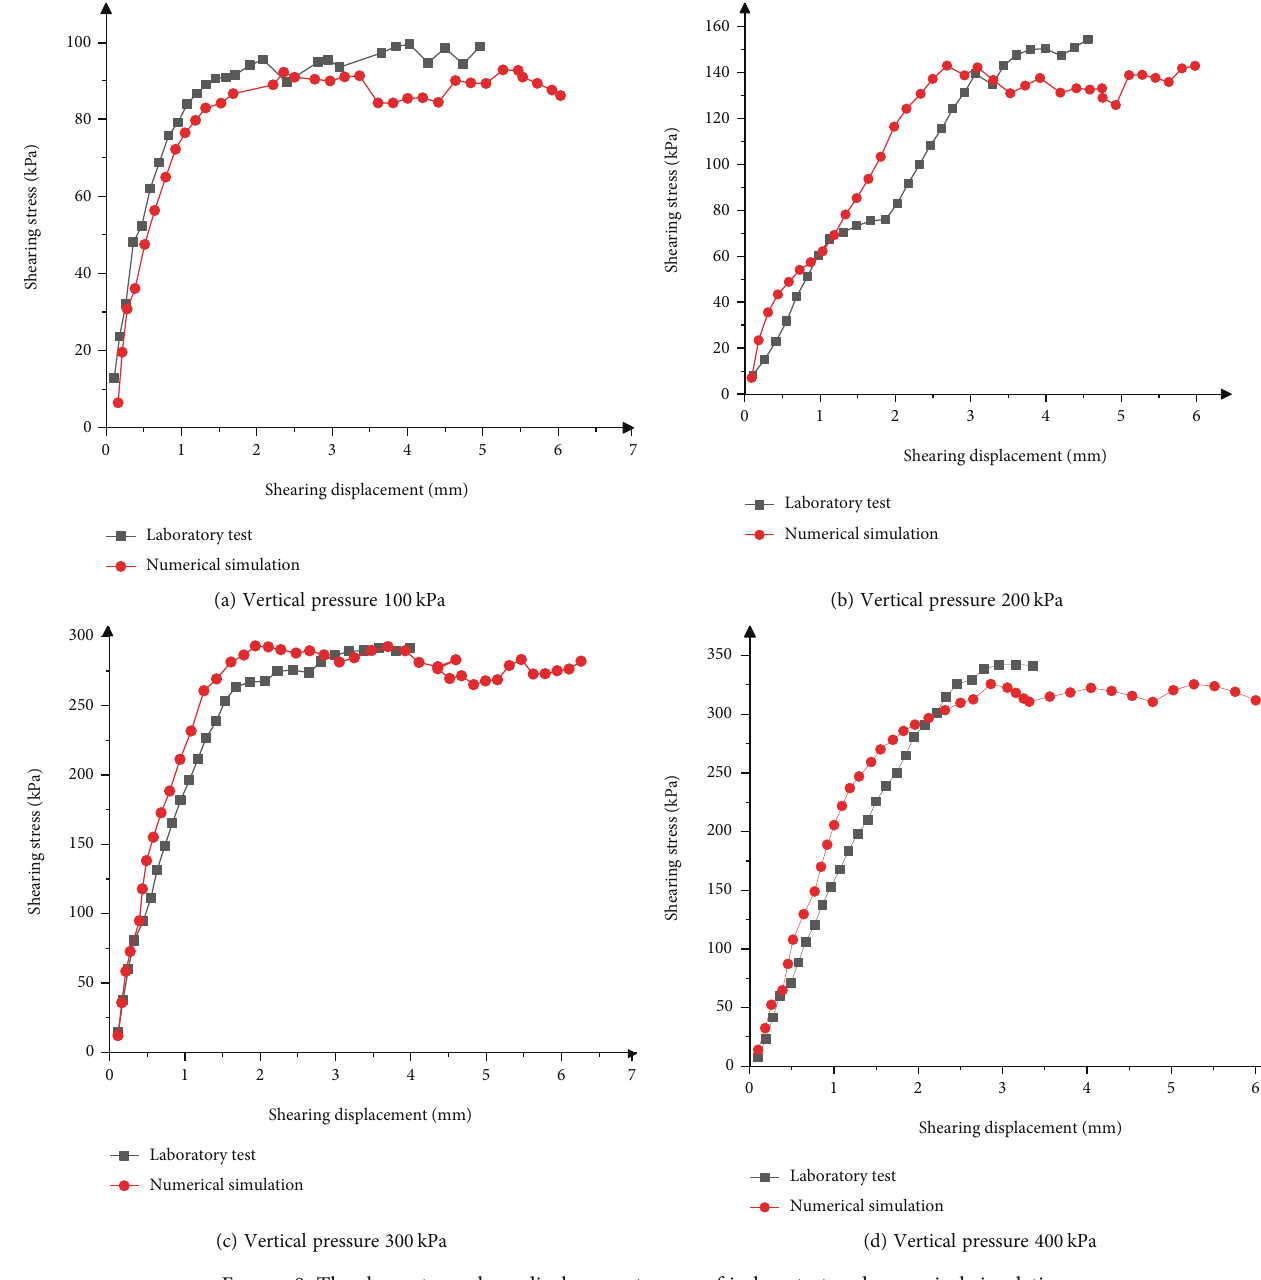
Figure 8: The shear stress-shear displacement curve of indoor test and numerical simulation. Table 5: The results of direct shear test and numerical simulation are compared.